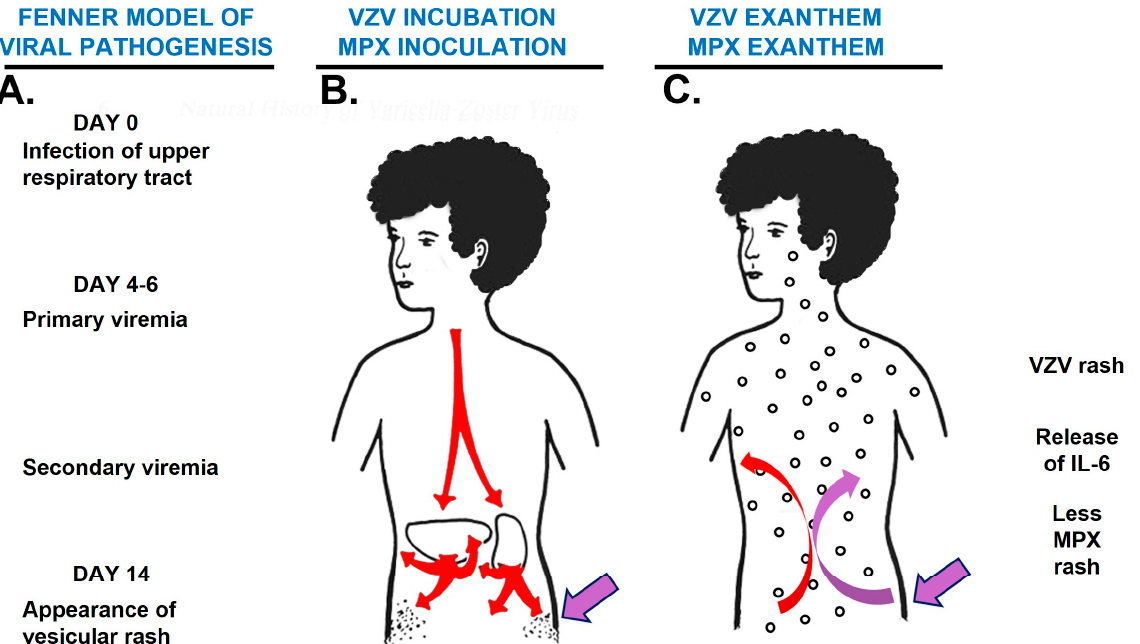
Figure 1. Pathogenesis of chickenpox (varicella) alone and coinfection of varicella and monkeypox. ( A ) Fenner model of varicella pathogenesis. The model includes two viremic episodes over a period of 14 days, after which the exanthem first appears. ( B ) A schematic drawing of the Fenner model. The varicella viremias are high-lighted with red arrows inside the body. During a viremia, the vesicles appear around 14 days after the first day of infection. The purple arrow on the left flank illustrates a potential site for monkeypox virus to enter through the epidermis within a varicella vesicle. ( C ) A schematic drawing of the dual exanthems following coinfection with varicella and monkeypox. The varicella viremia is drawn with red arrows and the monkeypox viremia is drawn with purple arrows inside the body. New pox lesions appear over a period of 5–7 days. The IL-6 marker indicates the release of IL-6 following varicella infection. The marker for less MPX rash means less rash that expected in a dual chickenpox and monkey infection. Concepts for this figure are derived from an earlier figure by an author of this publication [3]. Abbreviations: VZV, chickenpox (varicella); MPX, monkeypox.